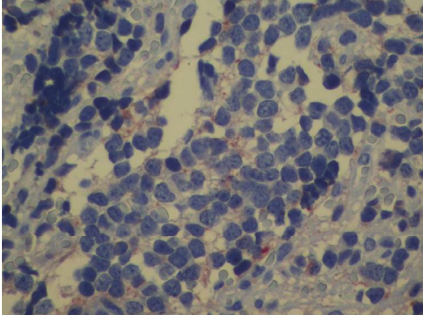
Figure 3: Histopathology of the cyst composed of small round cells with rosette formation (synaptophysin stain,